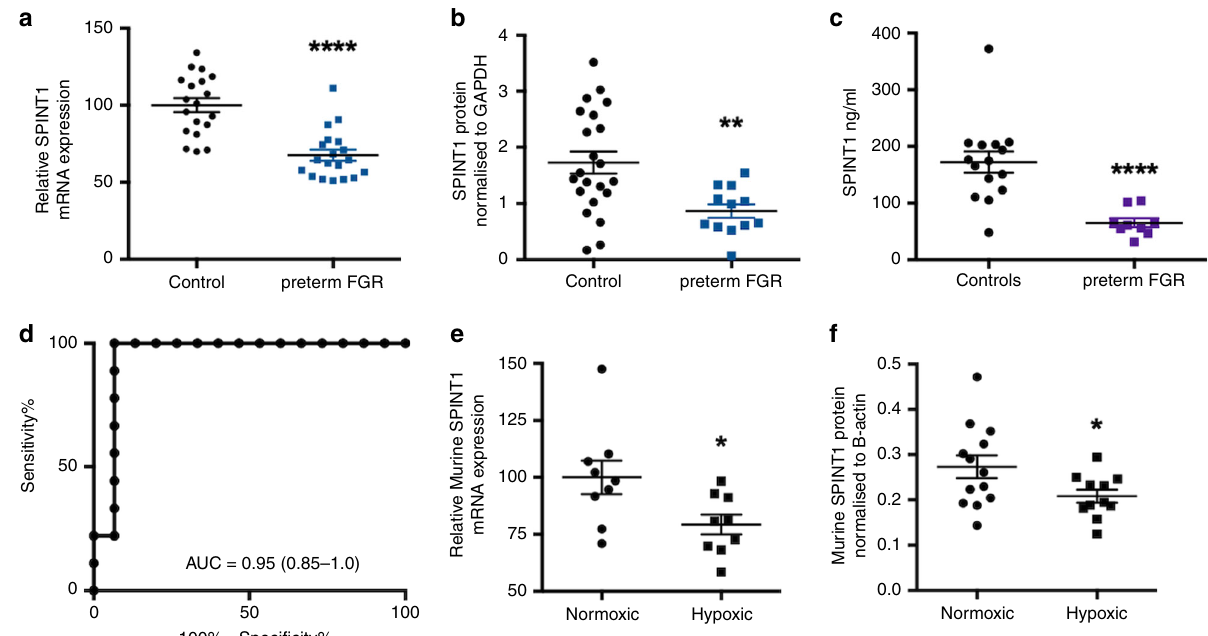
Fig. 4 SPINT1 is reduced in preterm fetal growth restriction. SPINT1 mRNA ( a , n = 19 control, n = 19 fetal growth restriction - FGR) and protein expression ( b , n = 22 control, n = 12 FGR) were signi fi cantly reduced in placentas from cases of preterm fetal growth restriction (FGR who were delivered <34 weeks ’ gestation and had a birthweight <10th centile) relative to gestation matched controls. Plasma SPINT1 concentrations were signi fi cantly reduced in women with preterm FGR relative to concentrations in women with healthy pregnancies, where bloods were collected at the same gestations ( c , n = 15 control, n = 9 FGR). The area under the receiver operated curve for data shown in c was 0.948 ( d ). In a mouse model of hypoxia-induced fetal growth restriction, SPINT1 mRNA ( e , n = 9 normoxic placentas, n = 9 hypoxic placentas from separate litters) and protein ( f , n = 13 normoxic placentas, n = 11 hypoxic placentas from separate litters) expression in the placenta was signi fi cantly reduced. * p < 0.05, ** p < 0.01, *** p < 0.001, **** p < 0.0001 using two- tailed Mann – Whitney U tests. Individual symbols represent an individual patient, placental isolation or placenta. AUC — area under the ROC curve, with 95% con fi dence intervals given in brackets. Data depicted for a – c , e , f are mean ± s.e.m. Source data included as a Source Data fi